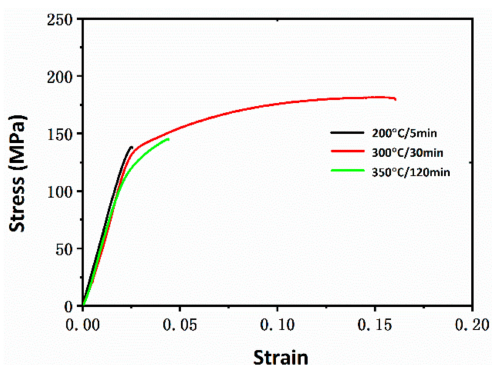
Figure 5. Strain–stress curves of Mg wires at 200 ◦ C / 5 min, 300 ◦ C / 30 min and 350 ◦ C / 120 min.